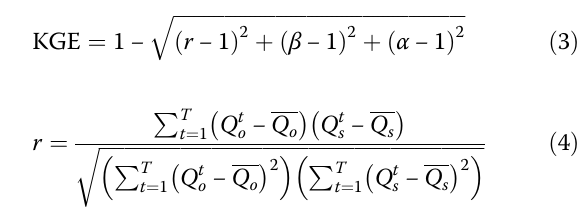
Table 3 Values of the verification metrics for the T19 simulation at each dam reservoir Dam name Region